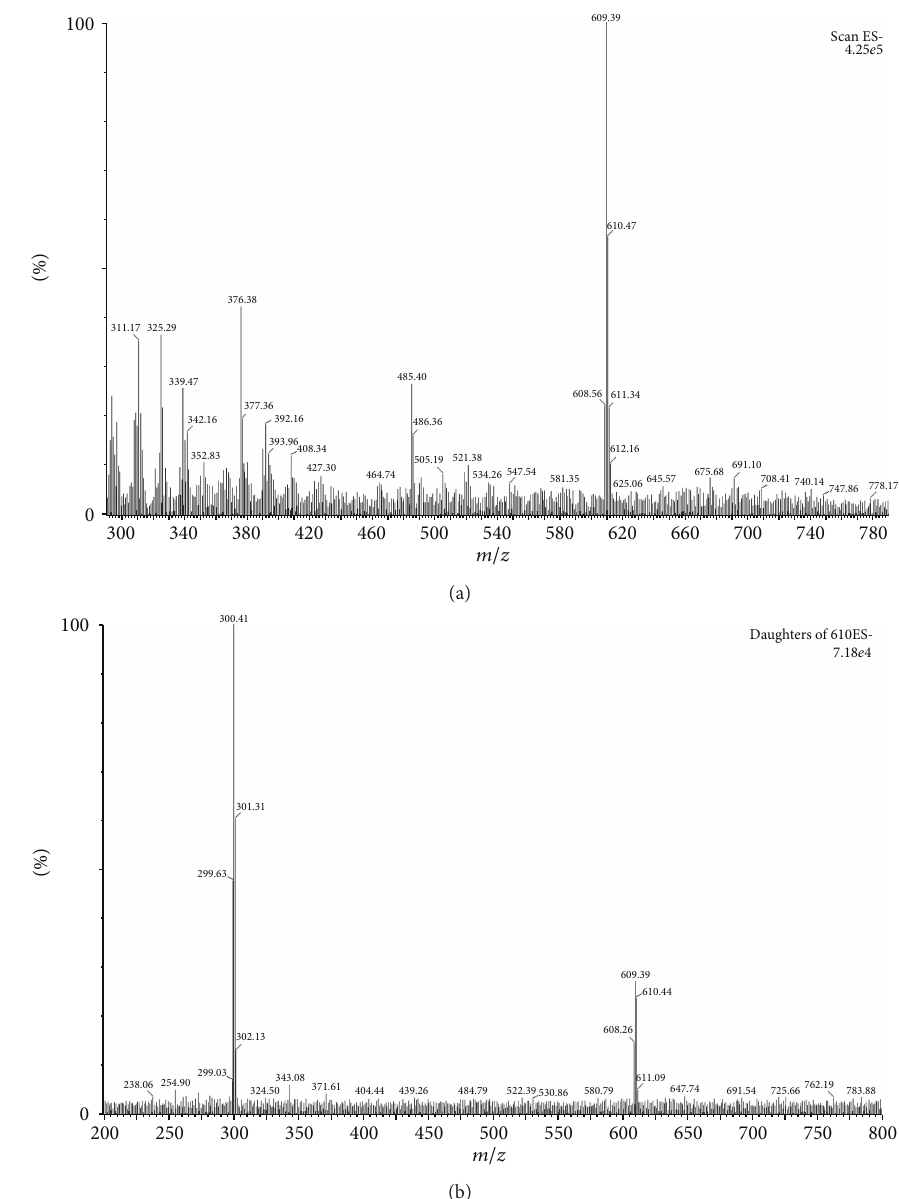
Figure 1: Mass precursor/product ion mass spectra of rutin. The parent ions of rutin were at m / z 609.4 (a), and the product ions of rutin were obtained at m/z 300.4 (b). The multiple reaction monitoring mass transition of rutin was at m / z 609.4 → 300.4 with a cone voltage of 40 V and collision energy of 32